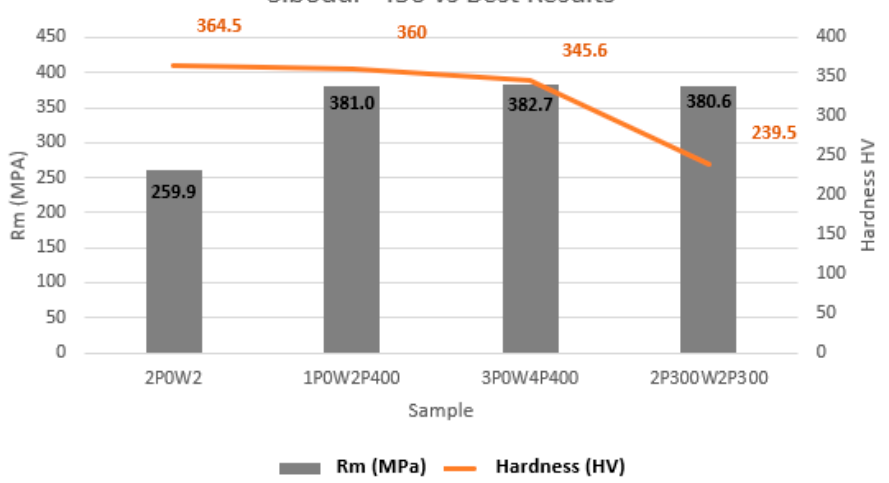
Figure 8 . Comparison of hardness in the HAZ and UTS of the samples 2P0W2P0, 1P0W2P400, 1P0W4P400, and 2P300W2P300.